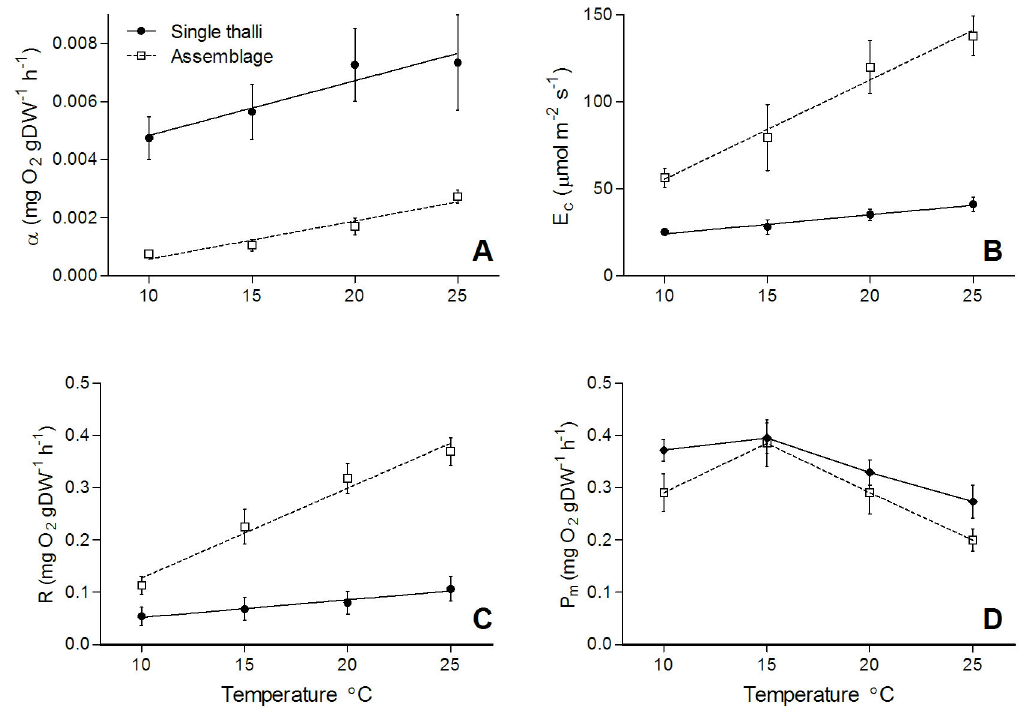
Figure 2. Effects of temperature on four photosynthetic parameters of H. banksii alone (single thalli) and H. banksii dominated assemblages (mean ±SE) in laboratory experiments. Parameters are the light-use efficiency or α (A), compensation point or E c (B), respiration or R (C) and maximum NPP or P (D) of P-E models. m doi: